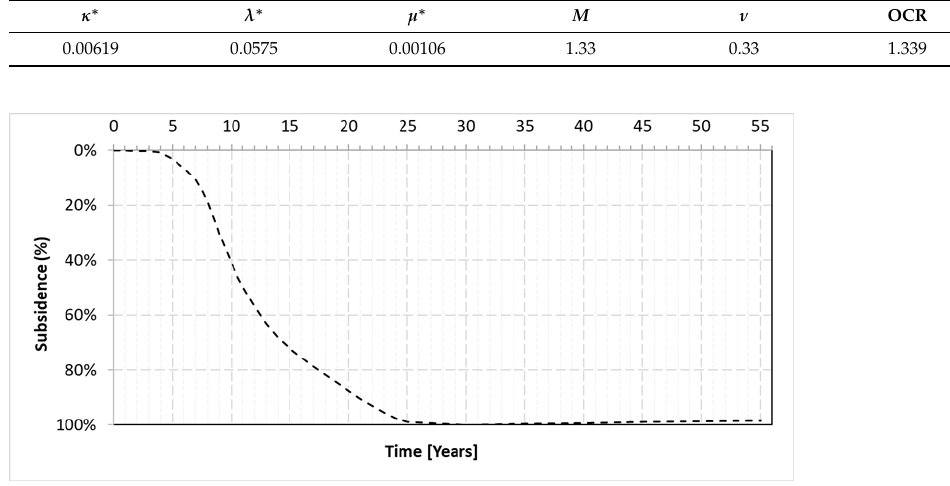
Figure 9. Subsidence evaluation for a real case study. Time evolution of the vertical displacement (normalized) at the point of maximum